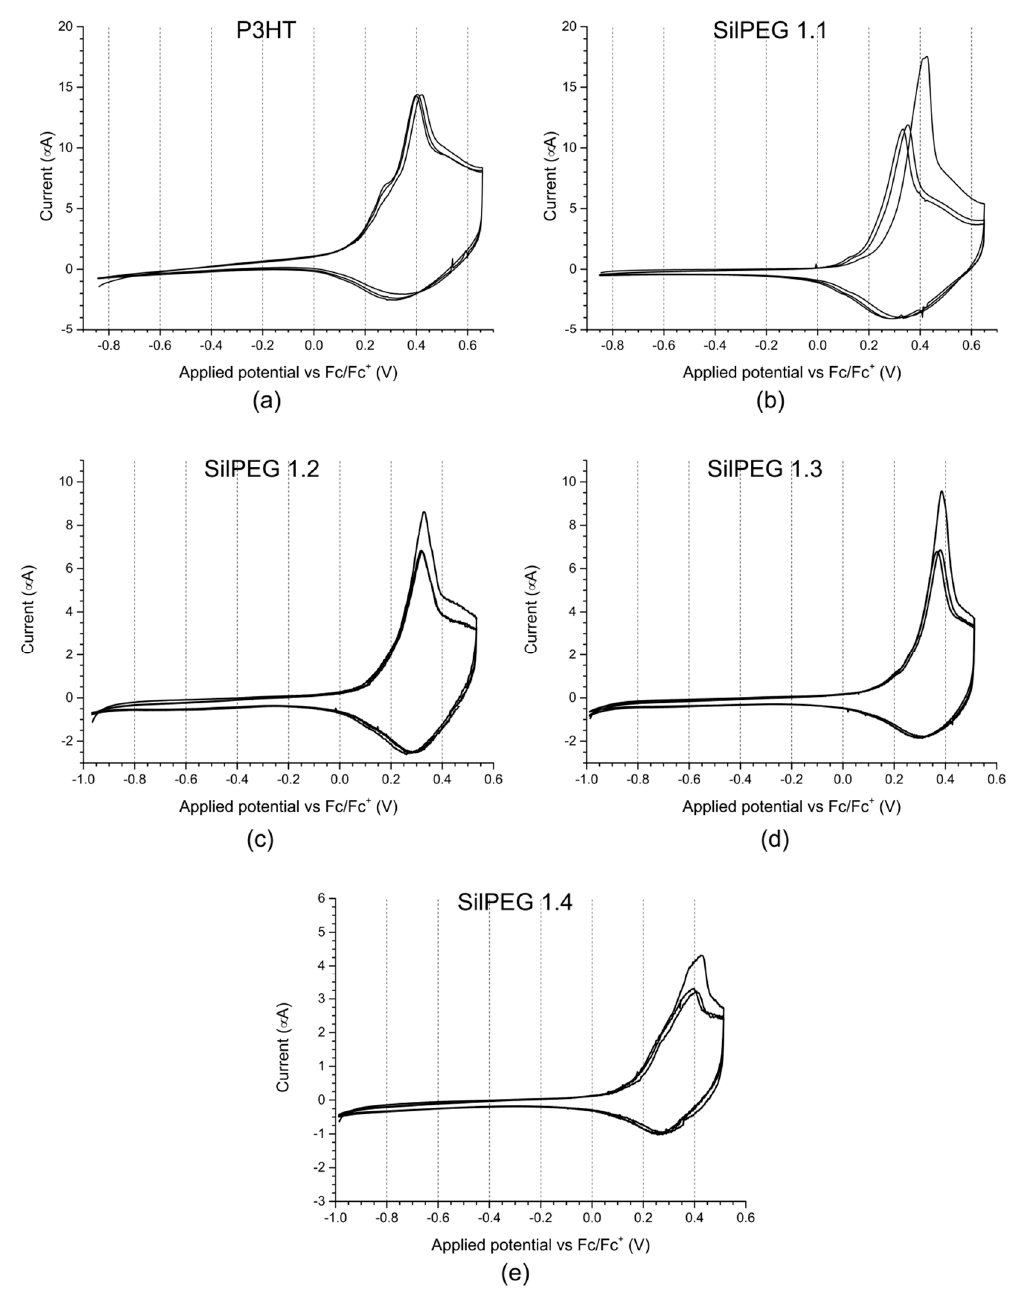
Figure 3. Electrochemical response of thin solid films of ( a ) regioregular P3HT; ( b ) SilPEG 1.1; ( c ) SilPEG 1.2; ( d ) SilPEG 1.3; ( e ) SilPEG 1.4 in 0.1 M tetrabutylammonium tetrafluoroborate/acetonitrile. Potential scanning rate r = 0.1 V/s.